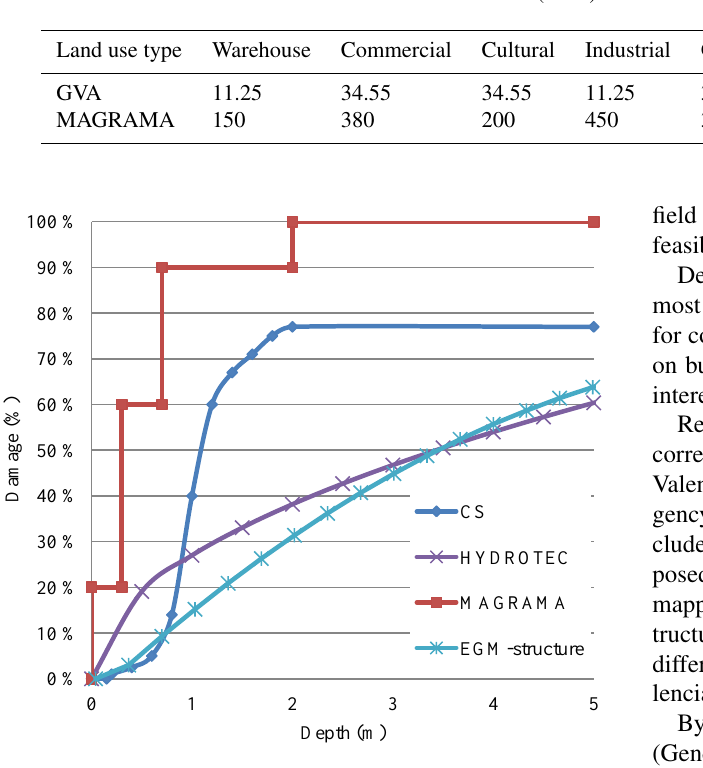
Figure 8. Examples of depth–damage functions compared to func- tion used for the case study analysis